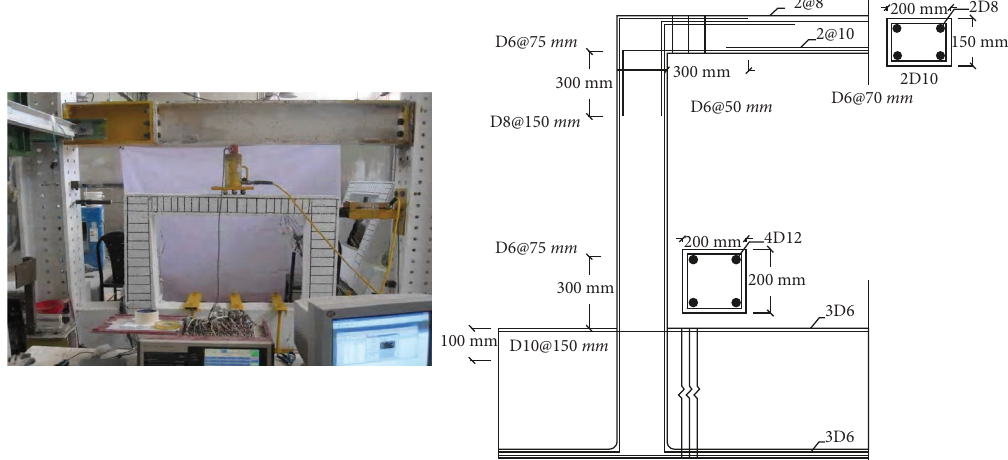
Figure 2: A view of the considered RC frame and details of the reinforcement layout of the frame [28].